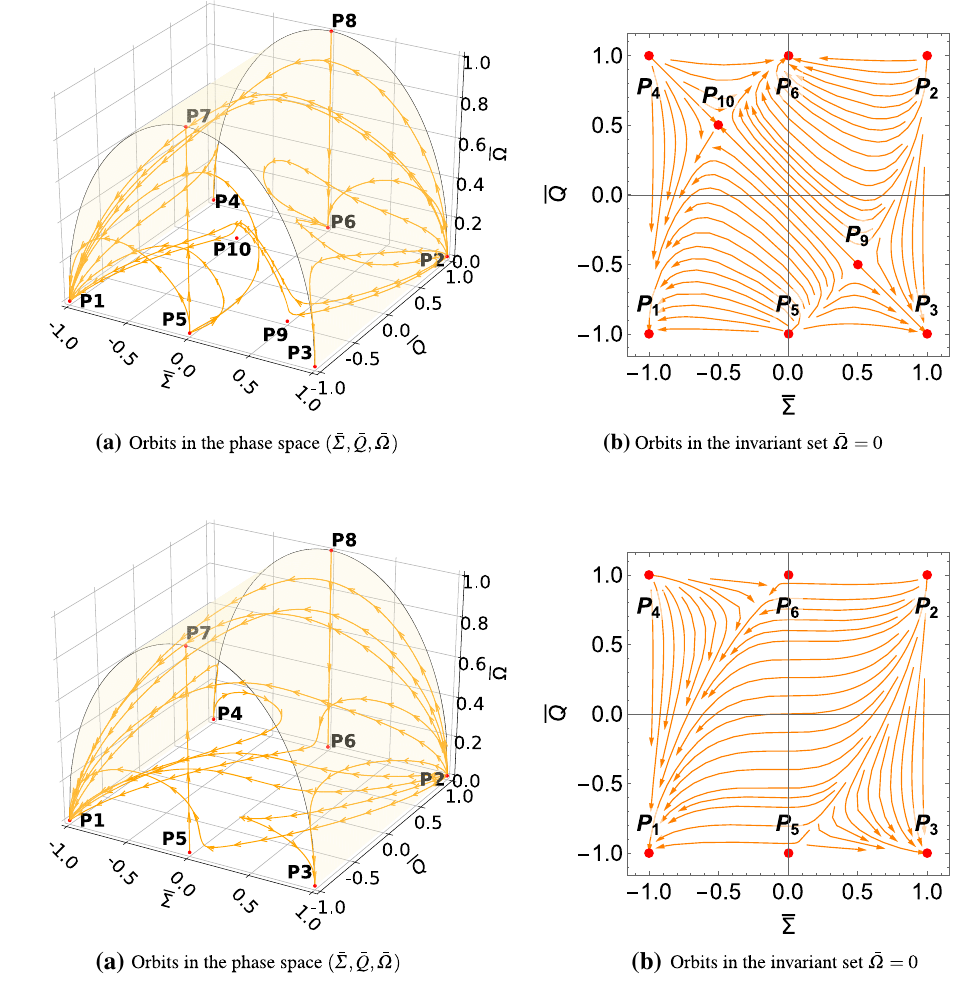
Fig. 4 Phase space of the guiding system (127a)–(127c) corresponding to KS for γ =